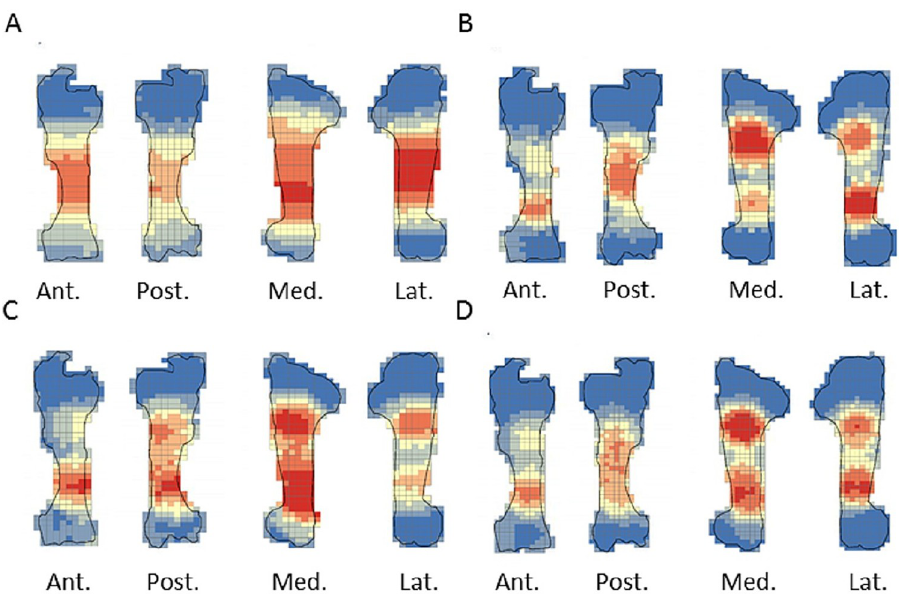
Fig 5. Optimized hot spot analysis of combined percussion marks from the humerus in each series. A- Individual n˚1; B- Individual n˚7; C- Individual n˚11; D- Merged humerus series (Ind.: Individual).